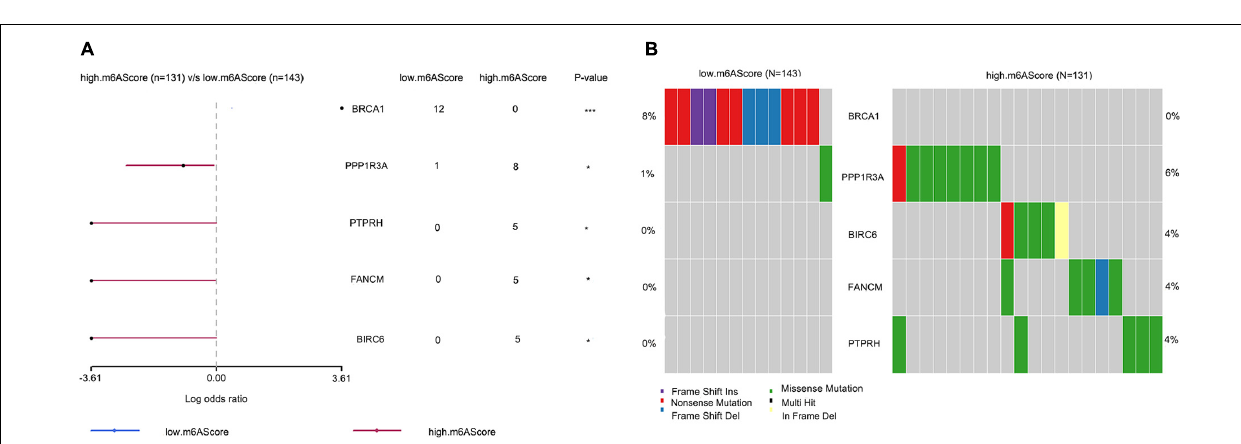
FIGURE 6 | Differences in genetic mutations between the high and low m6A score groups. (A) Forest plots showing five differentially mutated genes between the high and low m6A score groups. (B) Co-onco plots showing five differentially mutated genes between the high and low m6A score groups (* P < 0.05 and *** P <